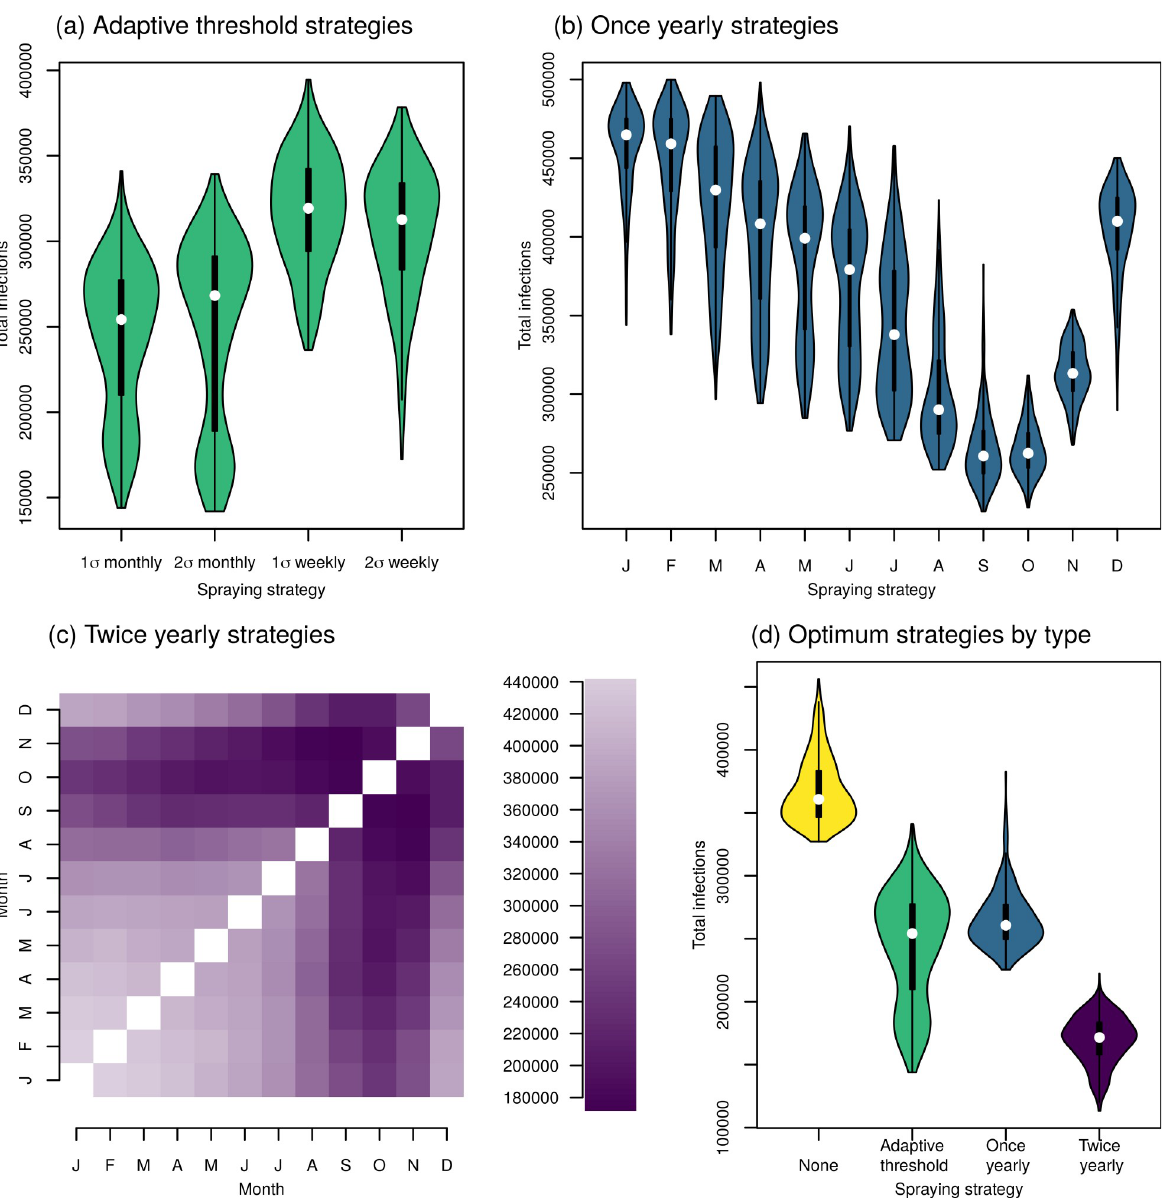
Fig 4. Predicted human infections following city-wide ULV spraying. (a) Comparison of adaptive threshold strategies for initiating spraying; spraying began when the monthly or weekly incidence was one or two standard deviations above the mean for that period from the last five years, as shown on the x-axis. (b) Comparison of yearly city-wide spraying strategies, beginning on the first day of the shown month. (c) Comparison of the median predicted infections for twice yearly spraying strategies, beginning on the first days of the shown month. Darker colors correspond to fewer infections, and the diagonal shows yearly spraying strategies. (d) Comparison of the best strategies in each category: adaptive threshold corresponds to starting when monthly incidence was more than one standard deviation above the mean, once yearly corresponds to spraying in September, twice yearly corresponds to spraying in September and